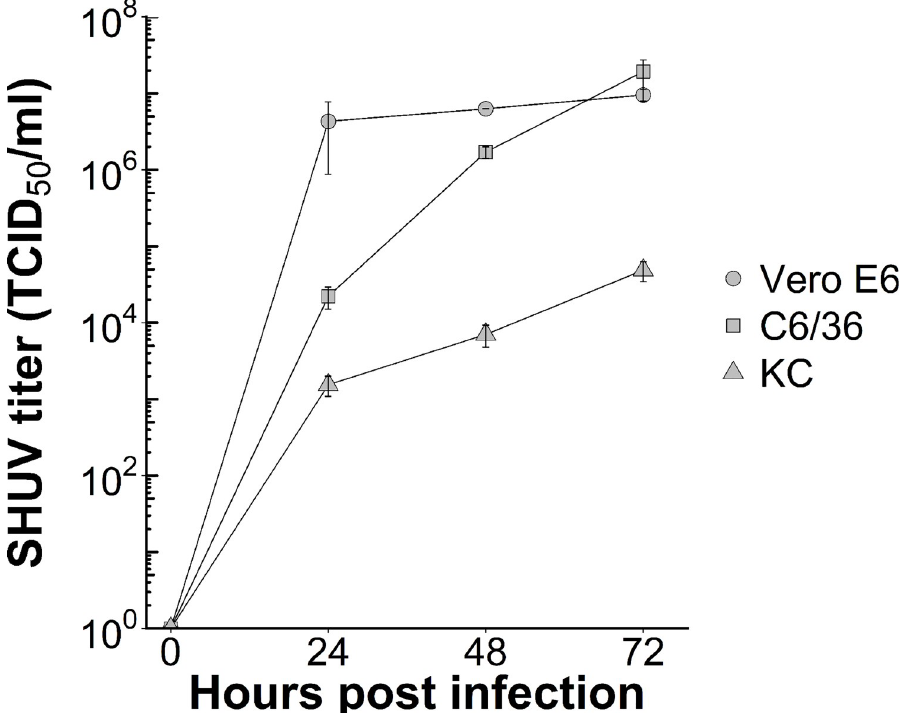
Fig 1. Growth of Shuni virus (SHUV) in mammalian (Vero E6), mosquito (C6/36), and Culicoides biting midge (KC) cells. Three different cell lines (Vero E6, C6/36, and KC cells) were inoculated with SHUV at an MOI of 0.01, and kept at 28˚C (C6/36 and KC) or 37˚C (Vero E6). Virus titers were determined at time points 0, 24, 48, and 72 h post infection. Mean virus titers ± SEM for three replicates are